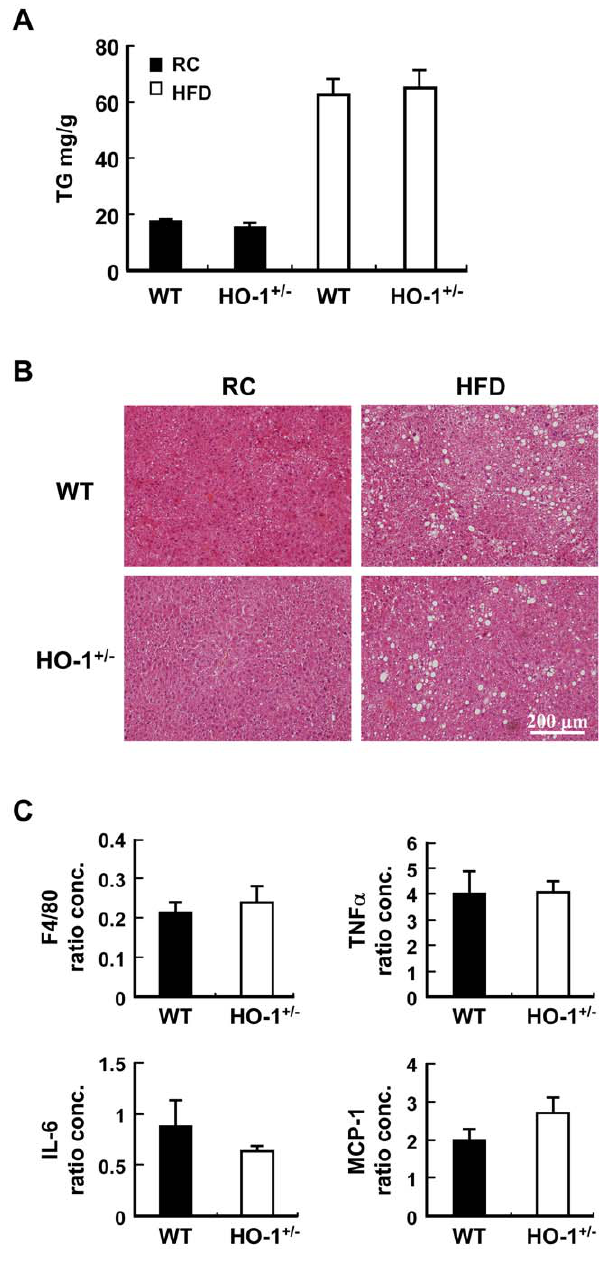
Figure 5. Hematopoietic HO-1 haploinsufficiency has no effect on HFD-induced liver steatosis. Chimeric mice harboring WT or HO- 1 + / 2 bone marrow were subjected to chow diet or HFD for 36 weeks. A, Liver tissues were collected and the TG contents were determined. The number of mice in each group is nine to ten. B, The representative images of the H & E stain. C, The expression levels of indicated genes in the livers of HFD-fed WT and HO-1 + / 2 chimeras. The number of animals in each group is